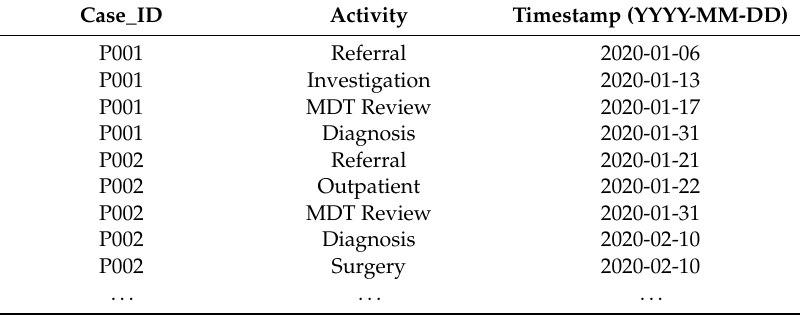
Table 1. An illustrative event log.